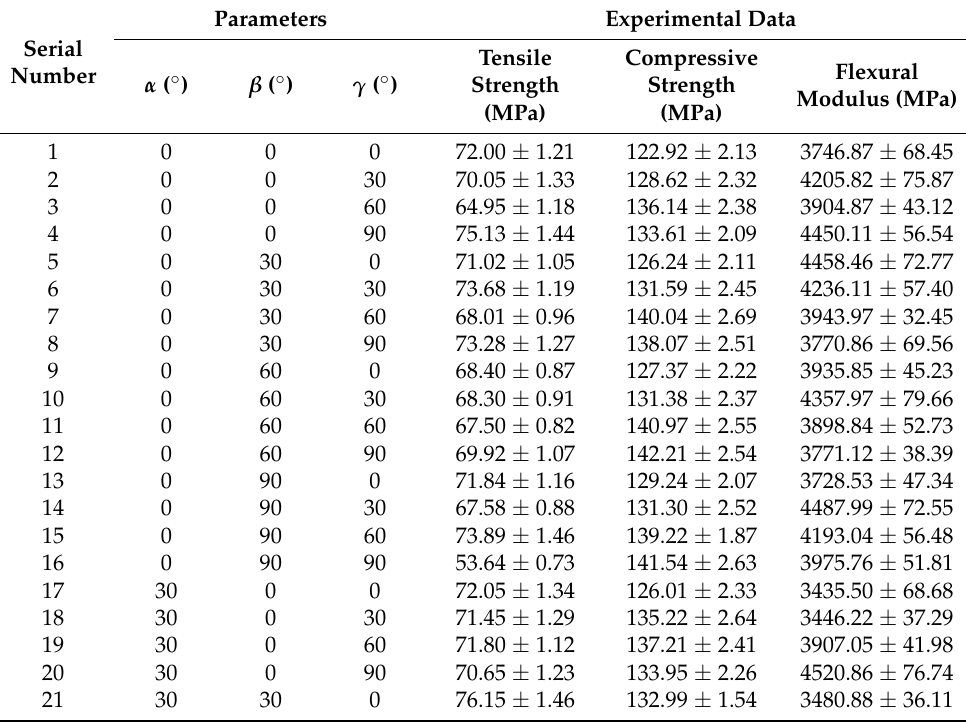
Table 3. The experimental data of mechanical properties for different printing